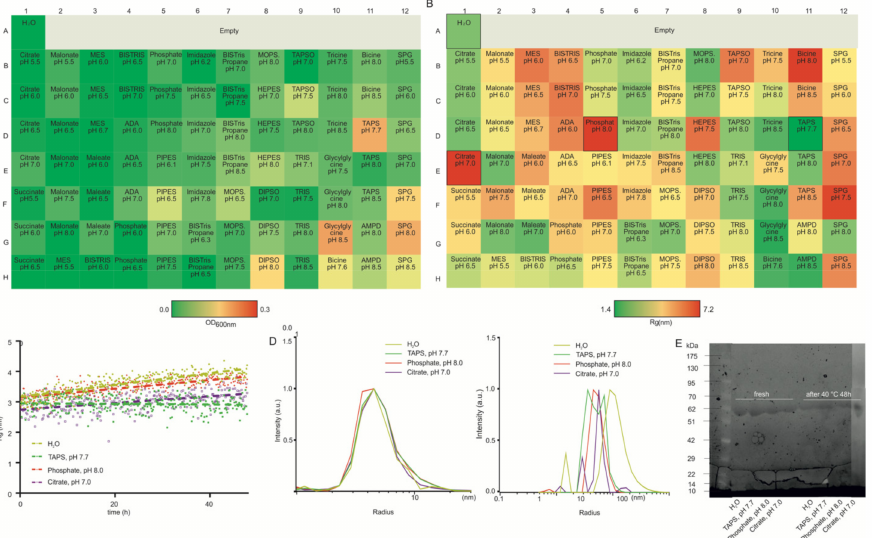
Figure 3. ( A ) A microplate assay for measuring OD 600 nm of HSA (5 mg/mL) colored by value (>0.5 means aggregation). ( B ) SAXS-based screening of HSA (5 mg/mL) colored by the value of the radius of gyration R g . ( C ) Changes in R g value were obtained for HSA at extreme formulations with 40 ◦ C. ( D ) Mean radii distribution of HSA at extreme formulations with 40 ◦ C before and after 48 h measured by DLS. ( E ) SDS-polyacrylamide gel electrophoresis (SDS-PAGE) of HSA incubated at extreme formulations with 40 ◦ C before and after 48